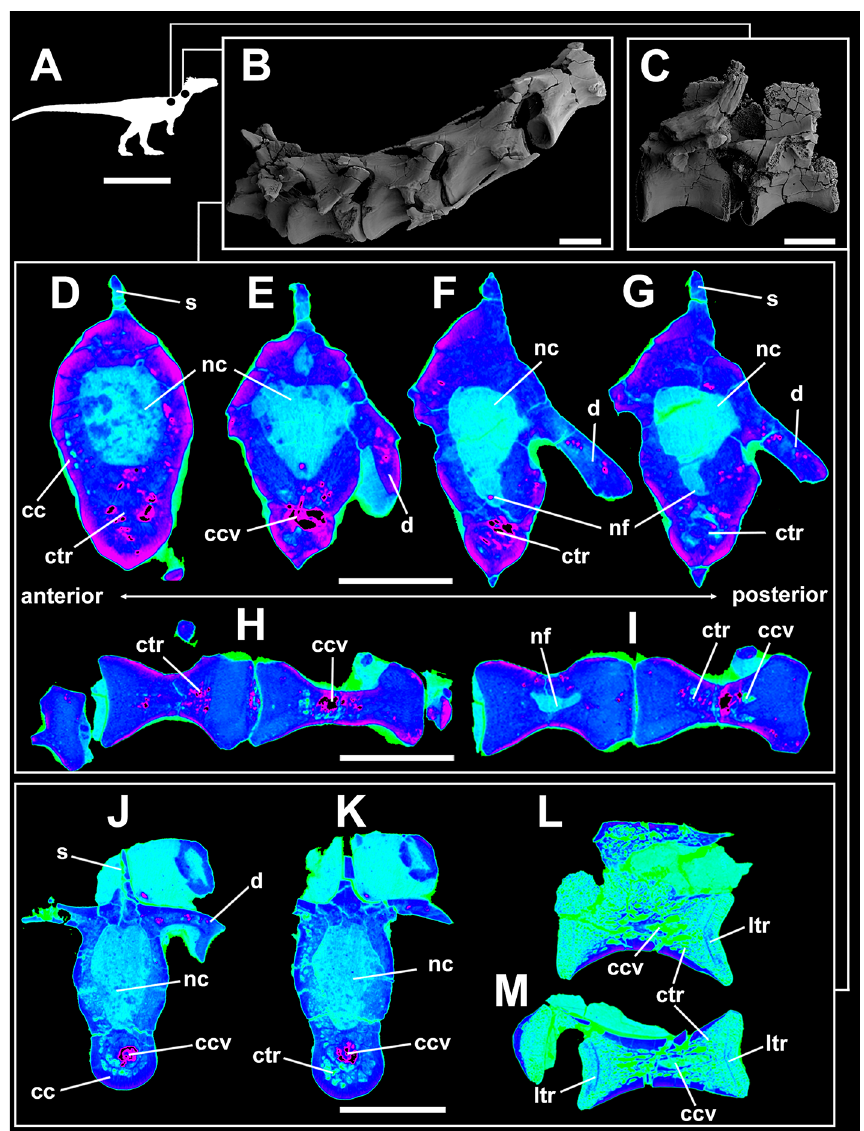
Figure 4. Micro-computed tomography of the vertebrae of the basalmost sauropodomorph Buriolestes (CAPPA/UFSM 0035). ( A ) silhouette shows the position of the axial elements. Artist: Felipe Elias. ( B ), three- dimensional reconstruction of the articulated cervical vertebral series and the correspondent high-contrast density slices in ( D–I ). Diagenetic processes partially compromised the internal structures in these cervicals. ( C ), 3D reconstruction of the articulated anterior dorsal vertebrae and the correspondent high-contrast density slices in ( J–M ). Small circumferential chambers occur both ventrally in the dorsal centrum ( J ) and laterally in the neural arch pedicles ( D ). All images indicate apneumatic chaotic trabeculae architecture. Some of the latter develop into larger chambers in the centrum ( E , J , K ). Nutritional foramina are broader at the bottom of the neural canal in the posterior cervicals ( F , G ). All slices were taken from the approximate midshaft. Anterior views in ( D–H , J , K ). Lateral view in ( L ). Ventral view in ( H , I , M ). Anterior/posterior orientation was defined based on the axial position, not the anatomical plane. cc circumferential chamber, ccv chamber in the centrum, ctr chaotic trabecula, d diapophysis, ltr layered trabeculae, nc neural canal, nf nutritional foramen, s neural spine. Scale bar in ( A ) = 500 mm; in ( B–M ) = 10 mm. Computed tomography data processed with 3D Slicer version 4.10. Figures were generated with Adobe Photoshop CC version 22.5.1